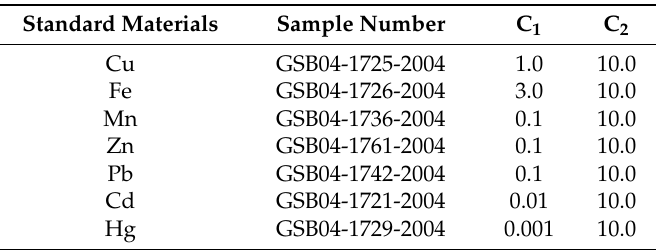
Table 1. Concentration values of the standard materials and the initial concentrations